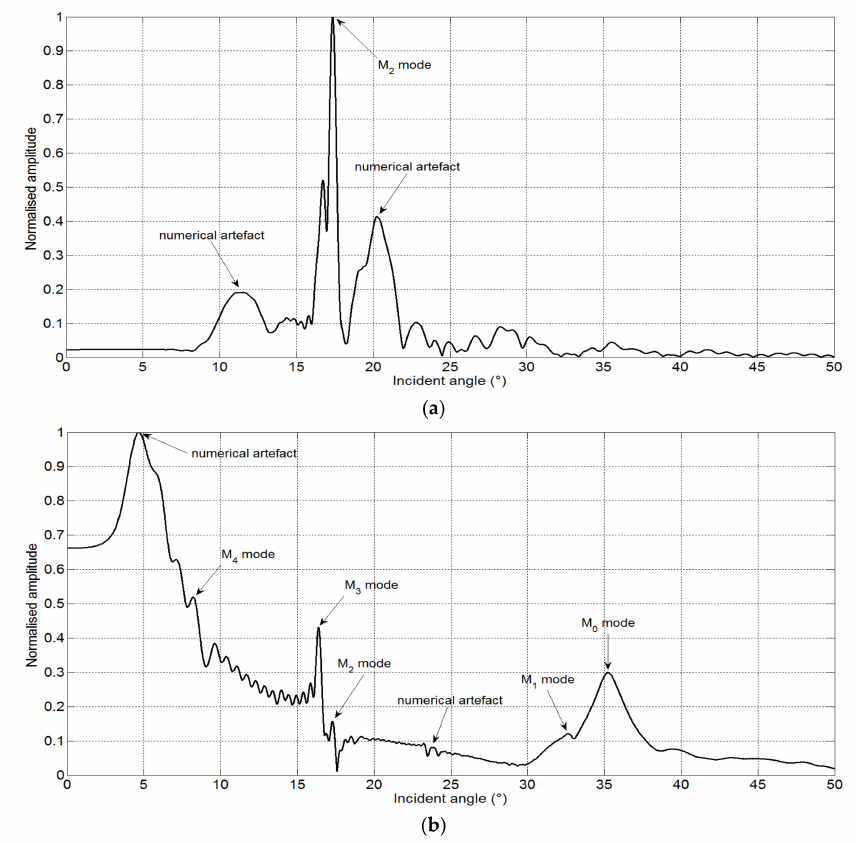
Figure 9. ( a ) Spectral representation of modes detected at 20 MHz with the segmented V ( z ) transducer; ( b ) corresponding spectra obtained with the classical V ( z )